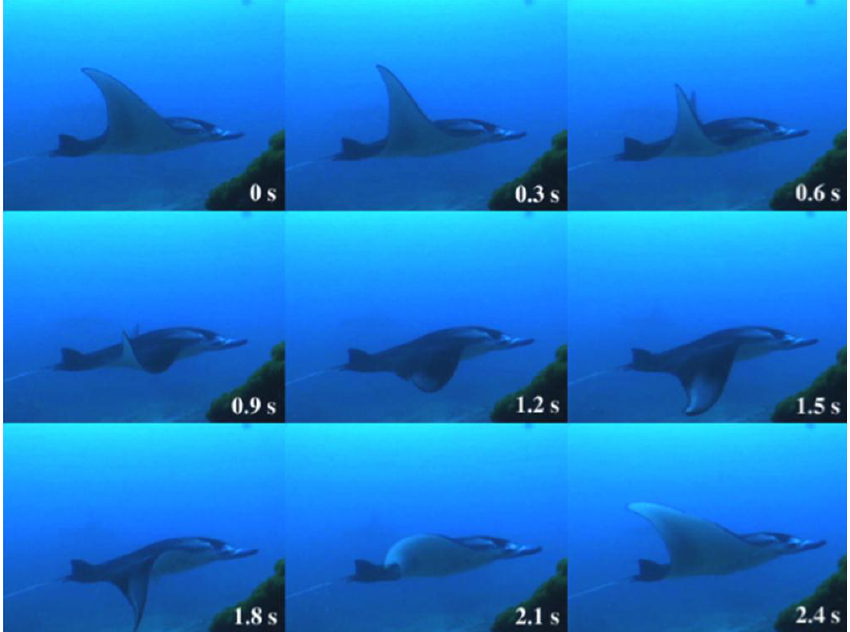
Figure 6. Sequential frames of video of propulsive movements of the pectoral fins of a swimming manta. The time elapsed between each frame is indicated in the bottom right corner of each frame. Video courtesy of Julie Morton, Yap Divers, Yap, Micronesia.